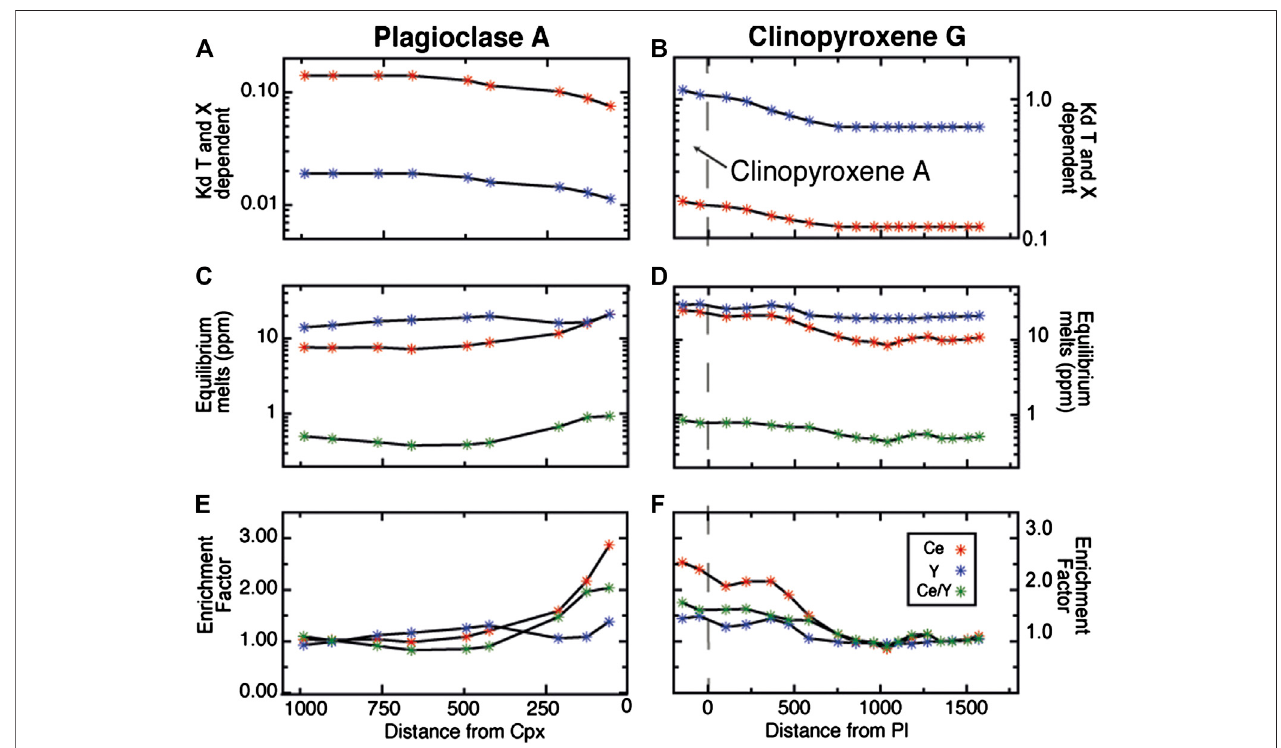
FIGURE9| VariationofCeandYpartitioncoef fi cients,Ce,Y(ppm)andCe/Yratio,andenrichmentfactorsoftheequilibriummeltsateachpointofthegeochemical transects in plagioclase and clinopyroxene from area A and G. The rim compositions of clinopyroxene A are reported as continuous with clinopyroxene G to better represent compositions in textural equilibrium with plagioclase A. Partition coef fi cients were calculated at speci fi c temperature (inferred from core and rim equilibration temperatures) and compositions (measured) using the parameterization of Sun and Liang (2012) for clinopyroxene and Sun and Liang (2017) for plagioclase (see textforfurtherdetails).TheenrichedfactoroftheequilibriummeltsiscalculatednormalizingtheCe,YandCe/Yratioofeachpointofthetwotransectstotheaveragecore compositions.